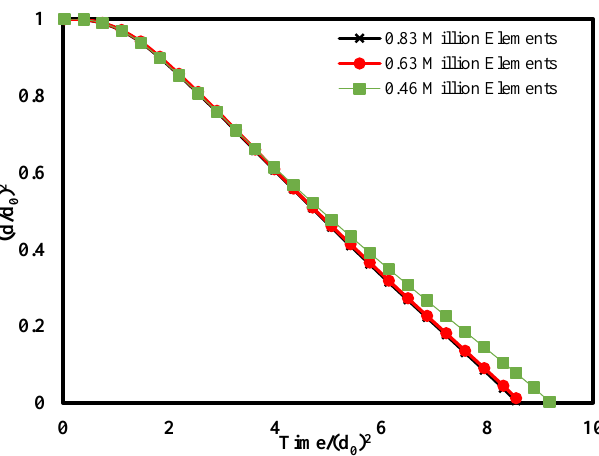
Figure 2. Mesh Independence Analysis.